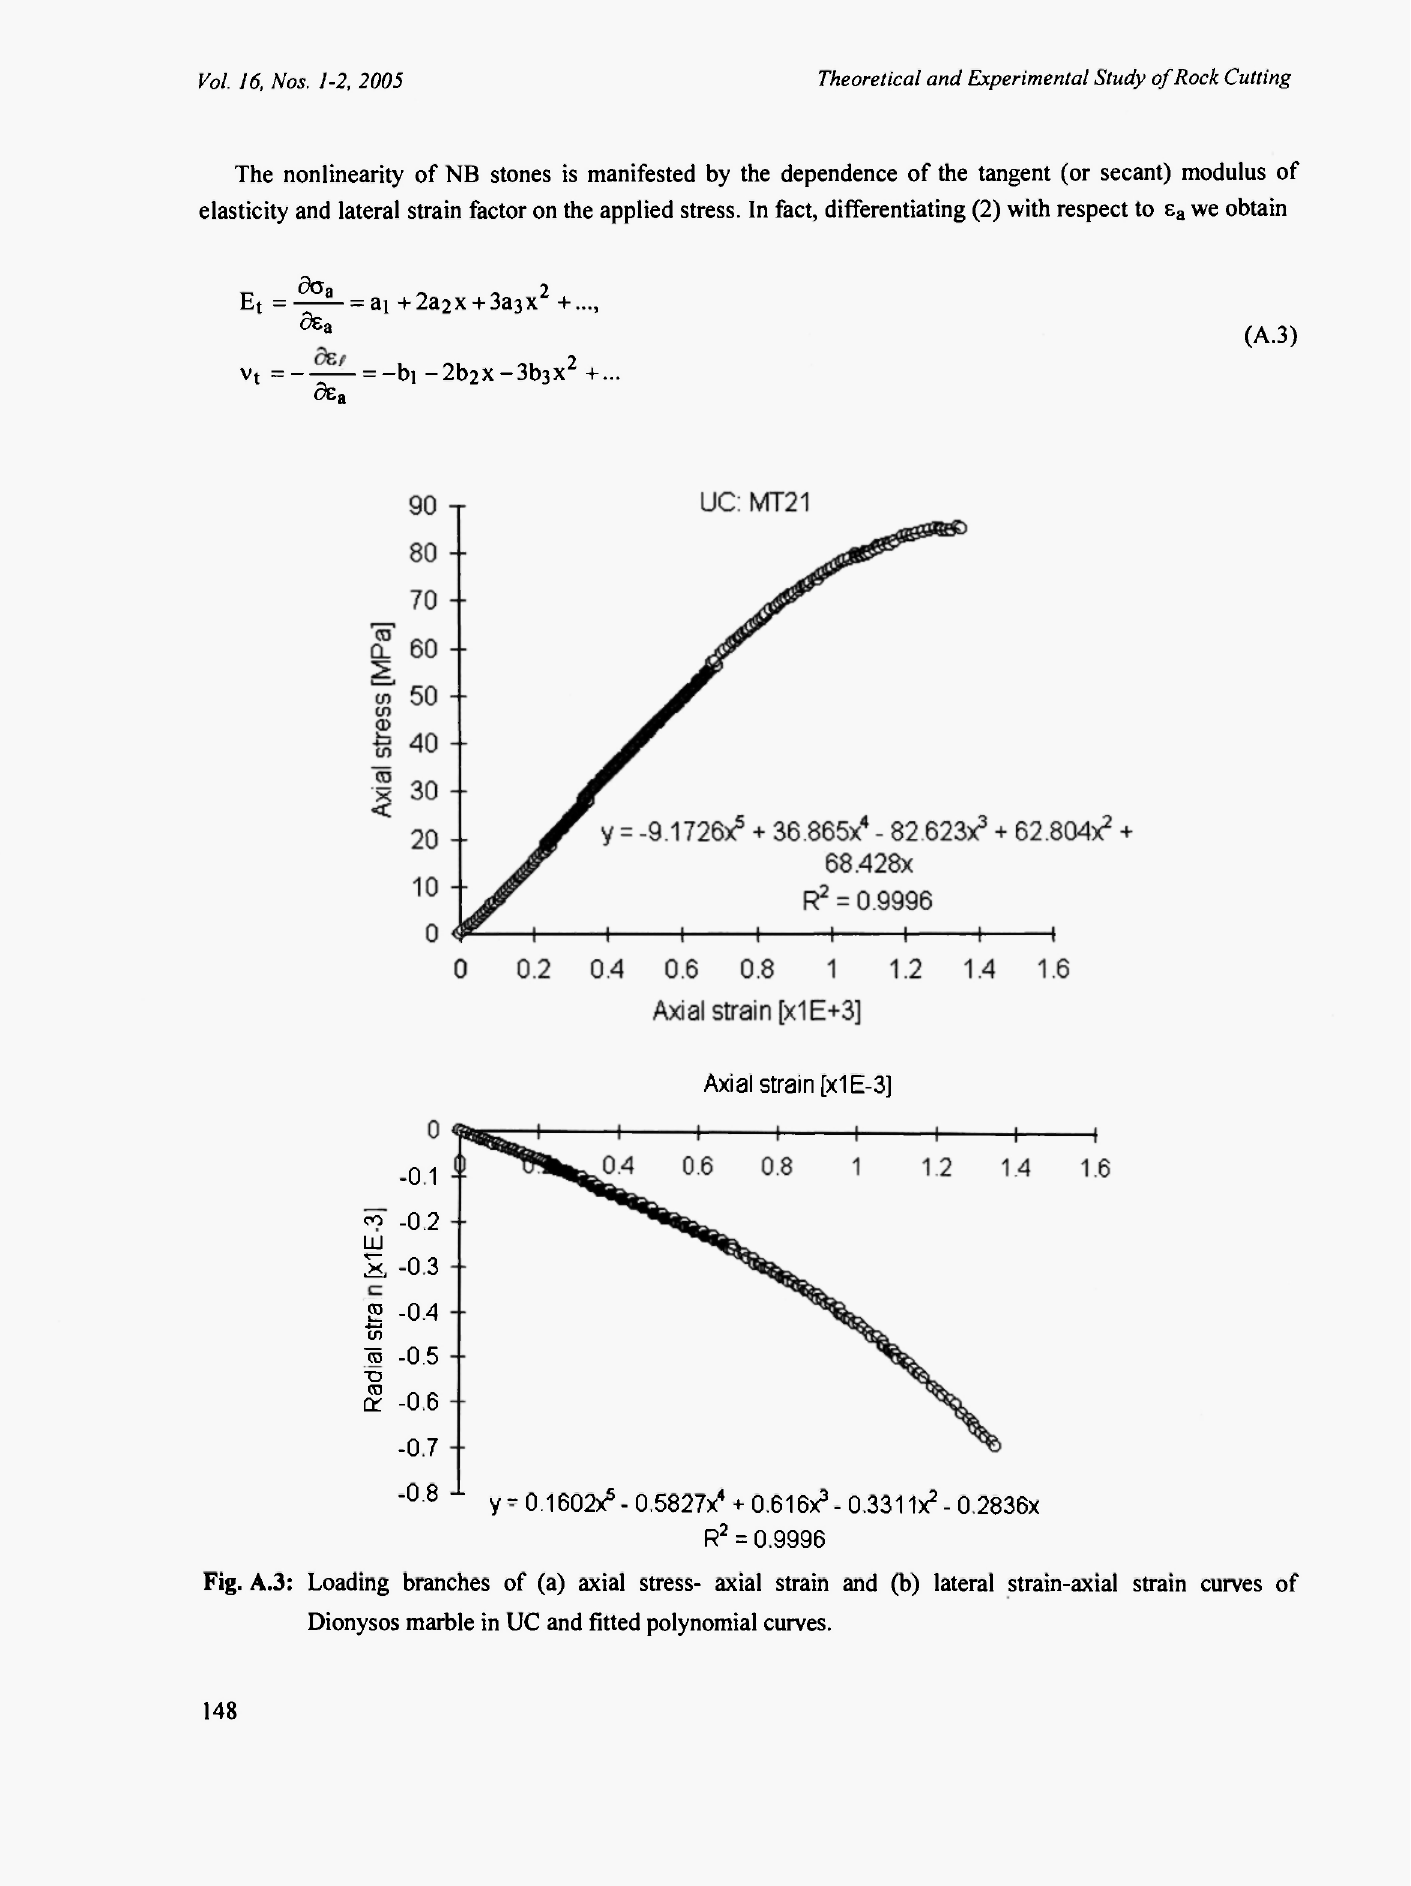
Fig. A.3: Loading branches of (a) axial stress- axial strain and (b) lateral strain-axial strain curves of Dionysos marble in UC and fitted polynomial curves.